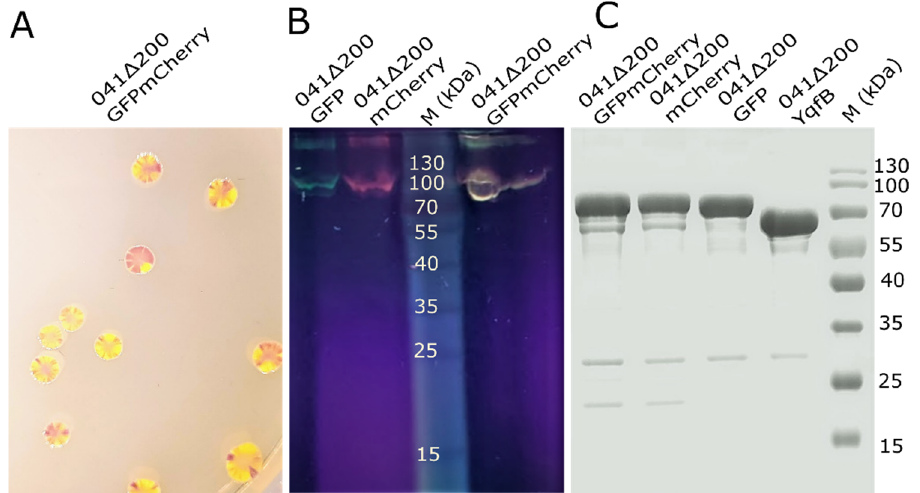
Figure 4. Analysis of chimeric 041 Δ 200 expression. ( A ) The individual colonies of E. coli BL21 (DE3) coexpressing 041 Δ 200GFP and 041 Δ 200mCherry; ( B ) purified chimeric 041 Δ 200GFP and 041 Δ 200mCherry proteins in polyacrylamide gel under UV light; ( C ) PAGE analysis of the purified 041 Δ 200GFP, 041 Δ 200mCherry, and 041 Δ 200YqfB proteins.